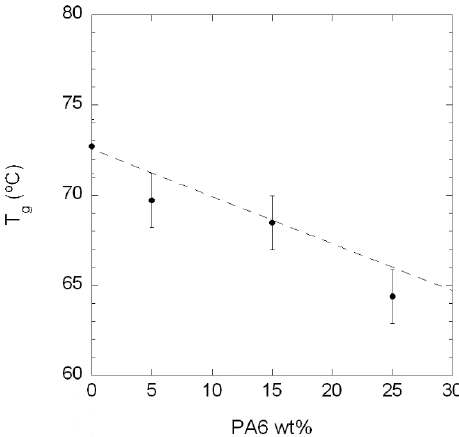
Figure 2. Glass transition temperature ( T g ) of the PA410/PA6 blends vs. PA6 content. The dotted line corresponds to the Fox equation for miscible blends [26].